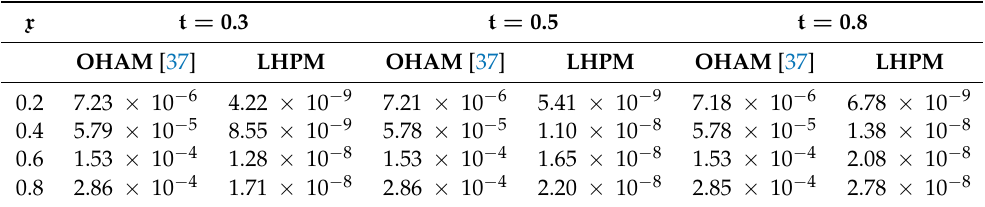
Table 7. Comparison of LHPM and OHAM errors in the Kaup–Kupershmidt model (Example 4) at different t when β = 0.5, λ = 0.1, w = 1, ρ = 2.5 and µ = 0.